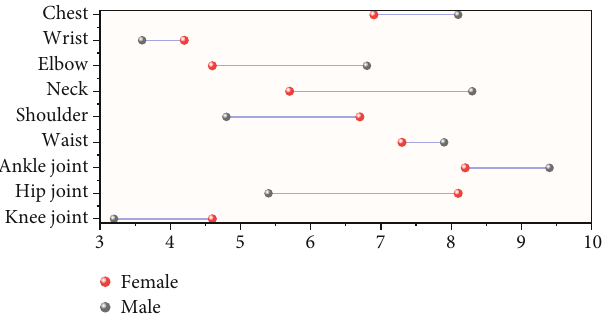
Figure 6: Statistical chart of sports injury and previous injury